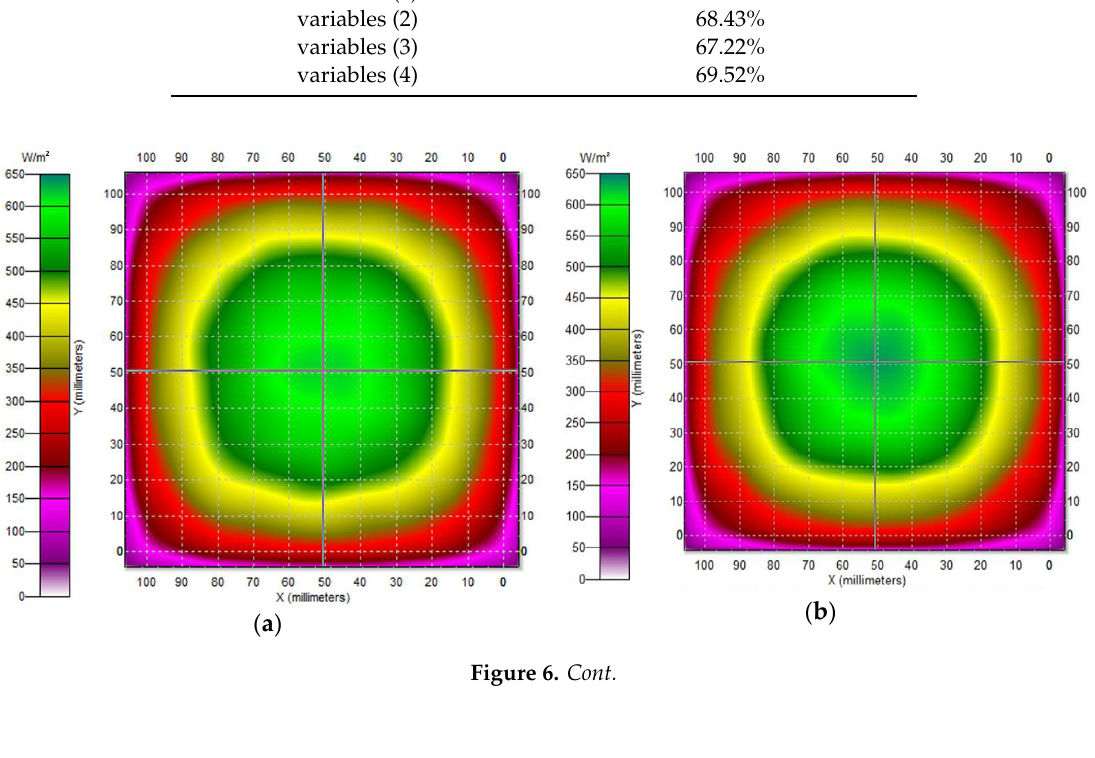
Table 3. Uniformity of type A simulation results.